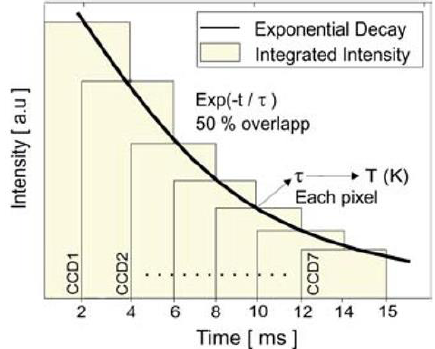
Figure 19. Lifetime computed from the single exponential decay at each pixel position. An overlap of 50% was used between the individual detectors [80]. Reprinted with permission from [80]. Springer Nature, 2004.